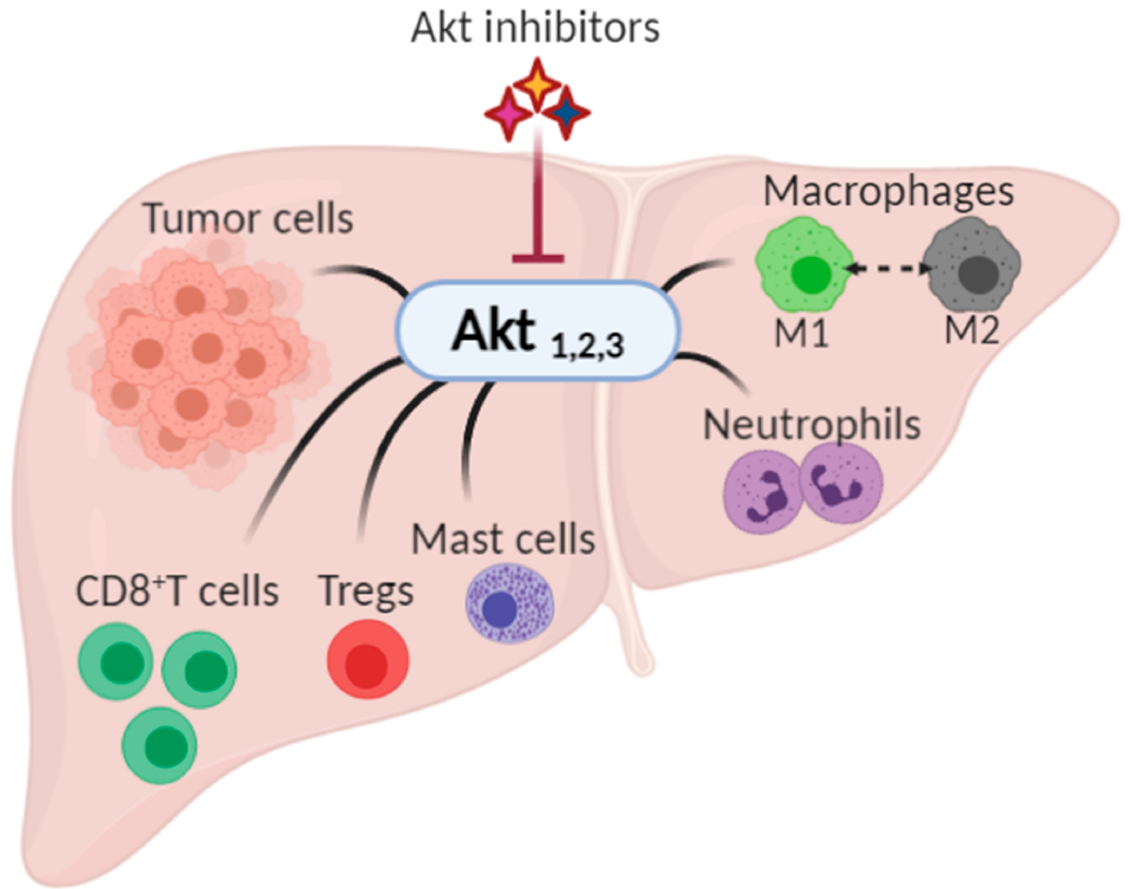
Figure 1. The possible impact of Akt inhibition on hepatocellular carcinoma and its tumor microenvironment. Akt, expressed as three isoforms, Akt1, Akt2, and Akt3, has been shown to play a role in the progression of cancer by controlling the growth, proliferation, and survival in tumor cells, and by modulating tumor microenvironment (namely CD8+ T cells, regulatory T cells (Tregs), mast cells, neutrophils, and macrophages).